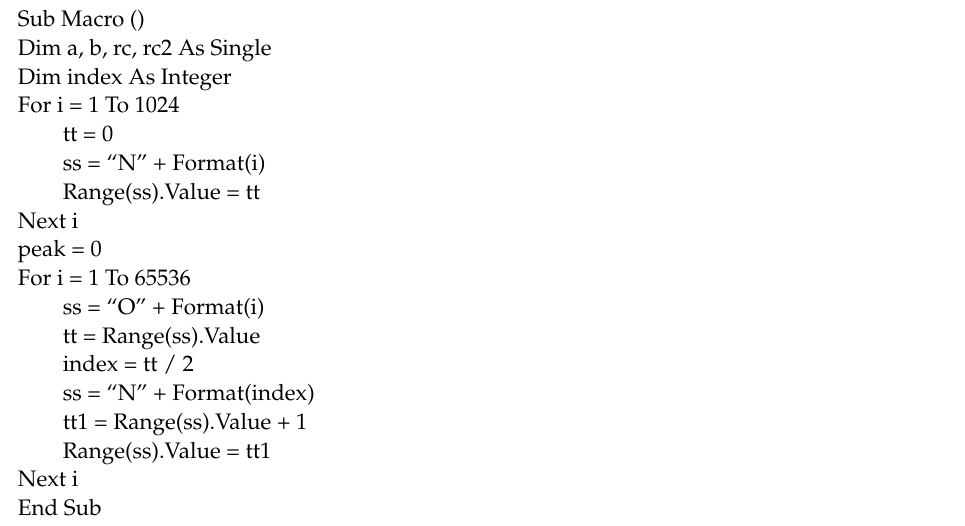
Algorithm 1 Multichannel spectrum generation